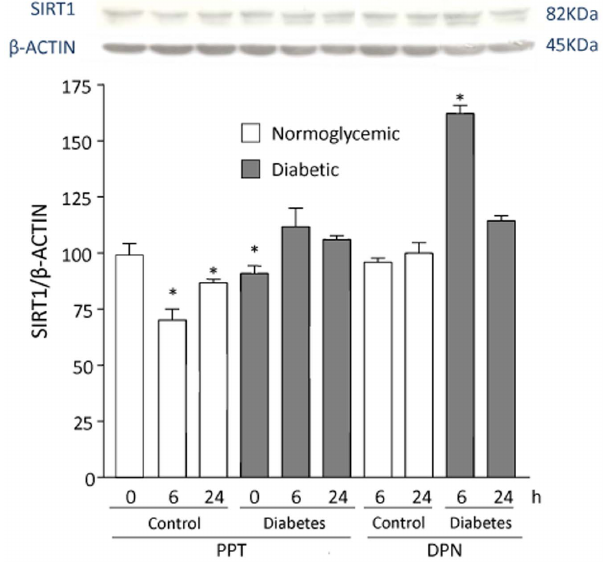
Figure 6. Effect of the selective ER a agonist PPT and the selective ER b agonist DPN on SIRT1 levels in VSMCs. VSMCs from normoglycemic and STZ-diabetic rats were incubated with PPT or DPN (0,1 m M) for 0, 6 and 24 h in 2% FBS phenol-red free culture medium, to avoid any interference from the weak estrogenic agent phenol red. SIRT amounts in normoglycemic VSMCs at baseline were taken as 100%. A representative Western blot is shown. Values are mean 6 SEM (n=3). * p , 0.05 vs control.